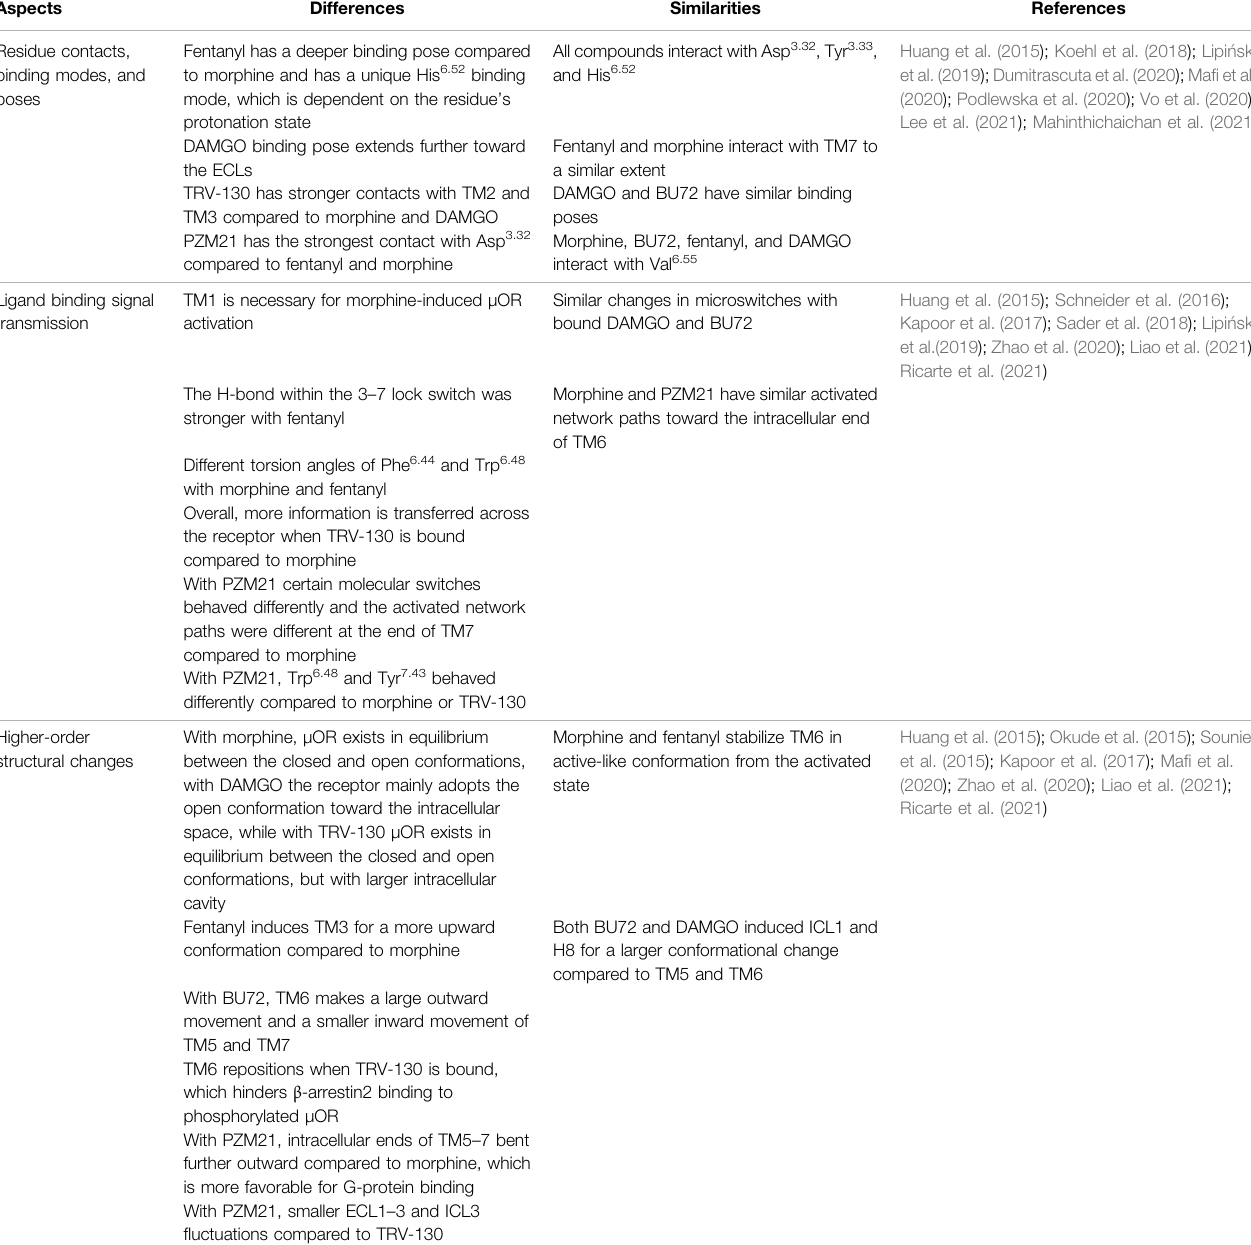
TABLE 1 | Main differences and similarities within the highlighted ligands once bound to the µOR in terms of ligand recognition, binding signal transmission, and global movements.